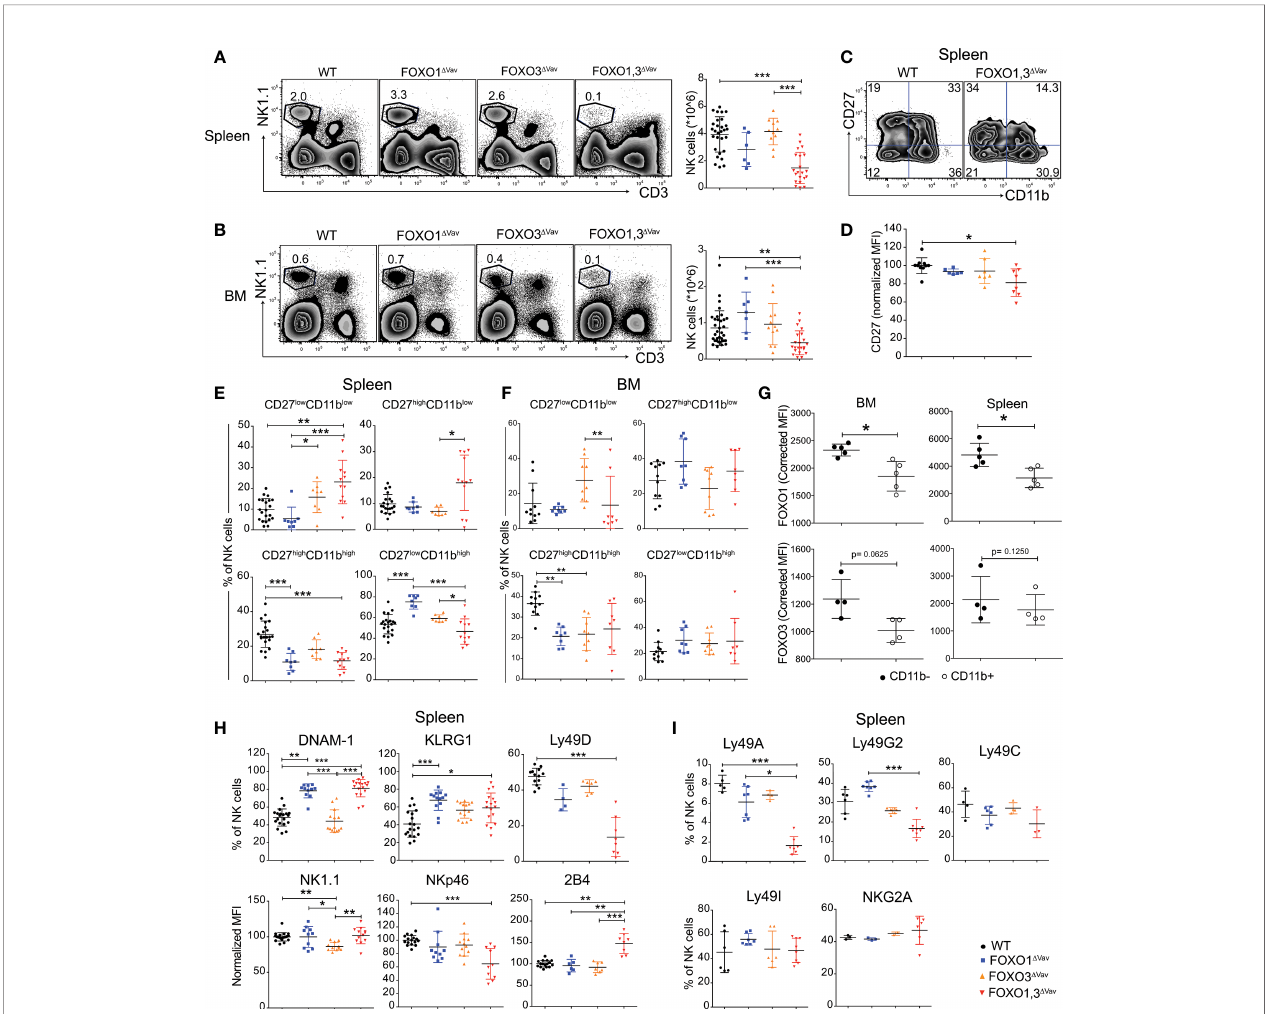
FIGURE 2 | NK cell development is dependent on FOXO1 and FOXO3. (A) Representative fl ow cytometry pro fi les (left panel) and total number of NK cells (single, live NK1.1 + CD3 - cells) (right panel) in spleen from animals with the indicated genotypes (n = 6-14). (B) Representative fl ow cytometry pro fi les (left panel) and total number of NK cells (single, live NK1.1 + CD3 - cells) in bone marrow (BM) (right panel) from animals with the indicated genotypes (n=7-17). (C) Representative fl ow cytometry pro fi les showing splenic NK cell maturation stages in animals with the indicated genotypes. (D) CD27 MFI of CD27 + NK cells from spleens (n = 6-12). (E) Frequency (%) of splenic NK cells from each indicated maturation stage ( n = 7-17). (F) Frequency (%) of BM NK cells from each indicated maturation stage ( n = 8-11). (G) FOXO1 and FOXO3 protein expression (MFI) in BM and splenic NK cells (n = 4-5) from WT mice. Data is from one representative experiment out of two independent experiments. (H) Frequency (%) or normalized MFI of indicated activating receptors on splenic NK cells ( n = 14-19). (I) Frequency (%) of splenic NK cells with indicated inhibitory receptors ( n = 3-8). In panels (A, B, D – I) : dots represent individual analyzed animals; bars indicate mean and SD; *, ** and *** indicates p-values <0.05, <0.01 and <0.001 respectively. P-values were calculated using: Kruskal Wallis tests with Dunn ’ s multiple comparisons test (panels A, B, D – F, H – I ) or the paired non-parametric Wilcoxon T test (panel G). Symbols utilized to indicate the genotype of analyzed mice throughout the panels are shown in the bottom right corner of the fi